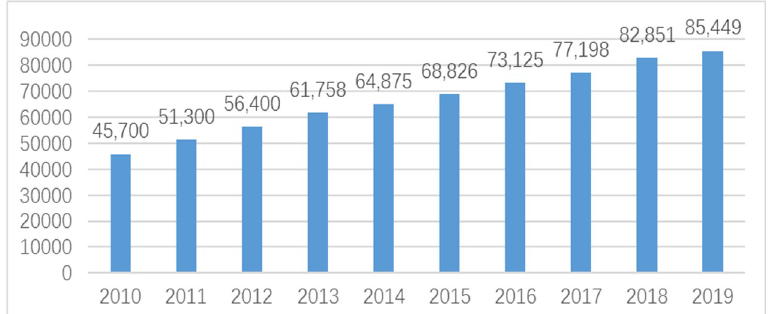
Fig 2. Change histogram of internet users from 2010 to 2019. Source: CNNIC, China Industrial Research Institute (http://www.199it.com/archives/tag/cnnic).